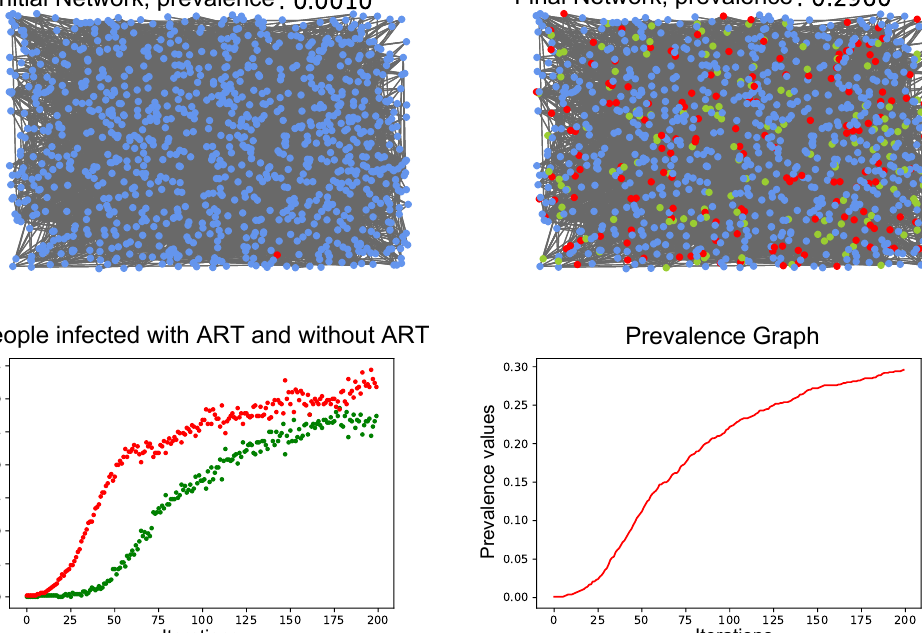
Figure 9. Uper : Simulation of the complex network for N T = 1000, τ = 200, γ = 3.4, and k = 4 (blue: susceptible people, red: carriers without ART, green: carriers with ART). Lower left : Graphic showing the relation between the HIV carrier population with ART (green) and the carrier population without ART (red). Lower right : Graphic of virus prevalence in the population. The scenario shown does not seek to represent reality, it only aims to illustrate the operation of the coupled